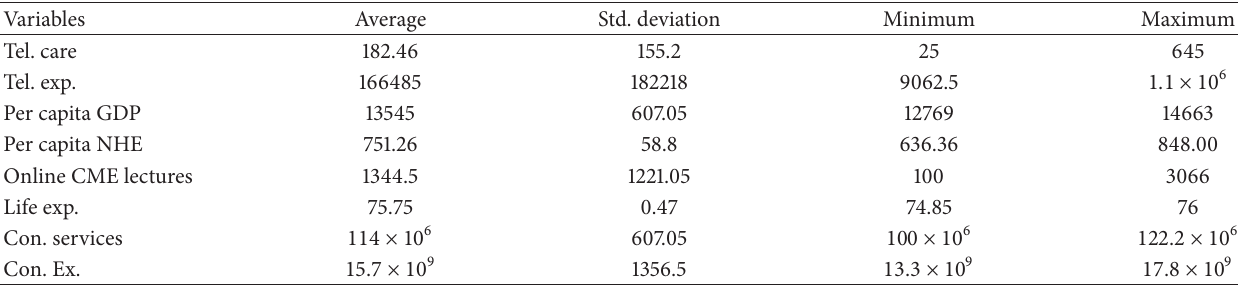
Table 1: Summary statistics.